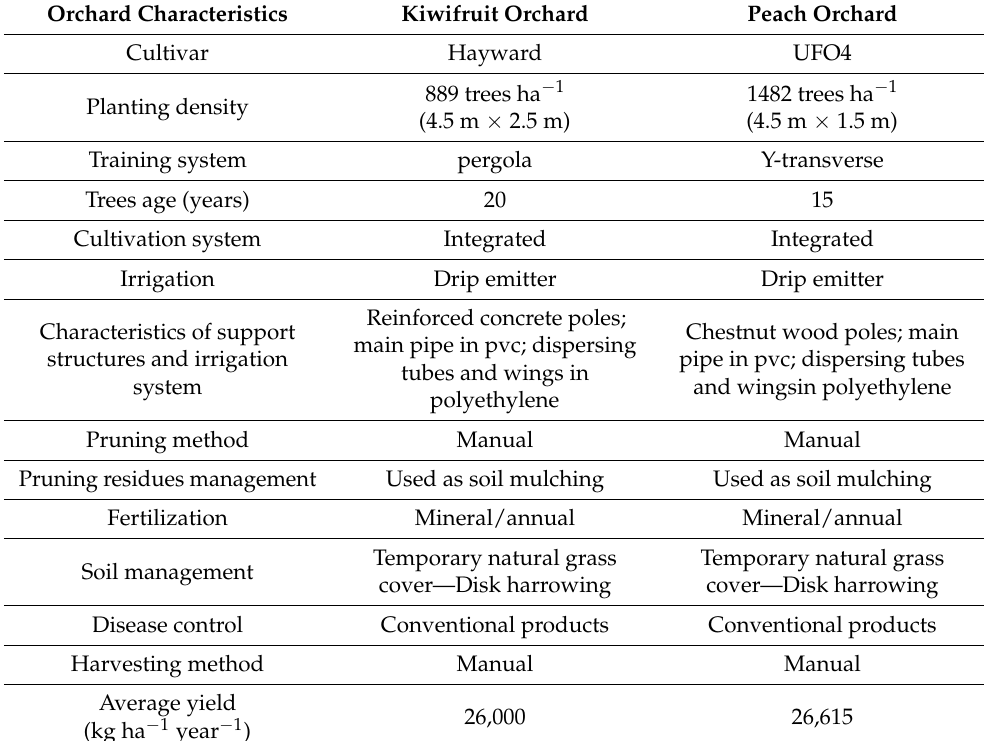
Table 1. Main features of the examined fruit orchard systems: kiwifruit orchard and peach orchard. Orchard Characteristics Kiwifruit Orchard Peach Orchard Cultivar